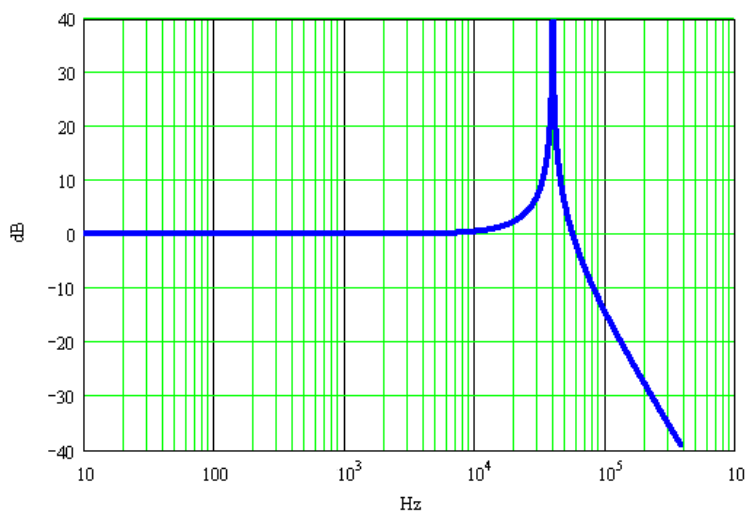
Figure 2. Amplitude-frequency characteristics of the accelerometer.